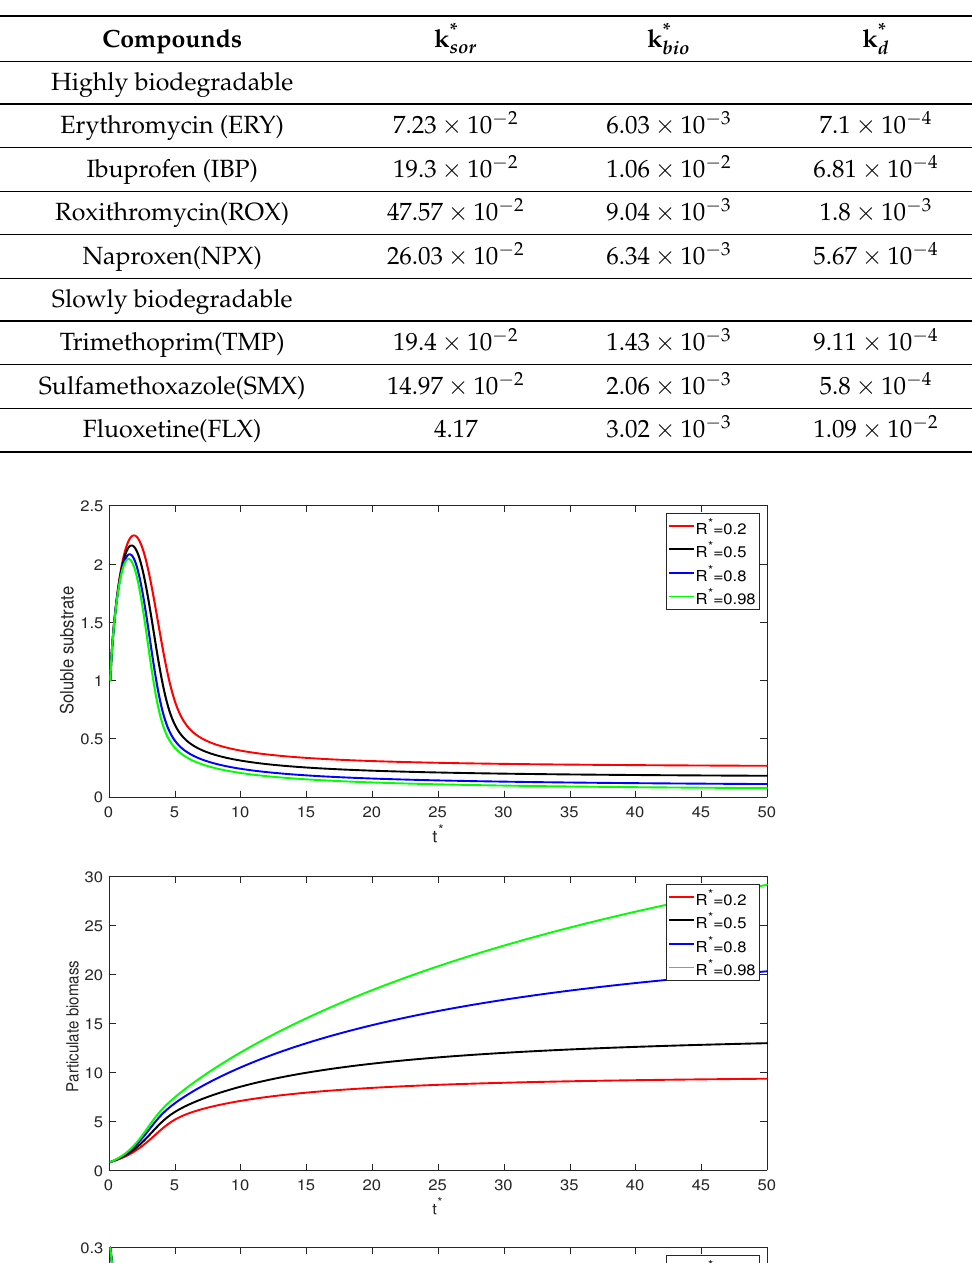
Table 1. Values of for different compounds.